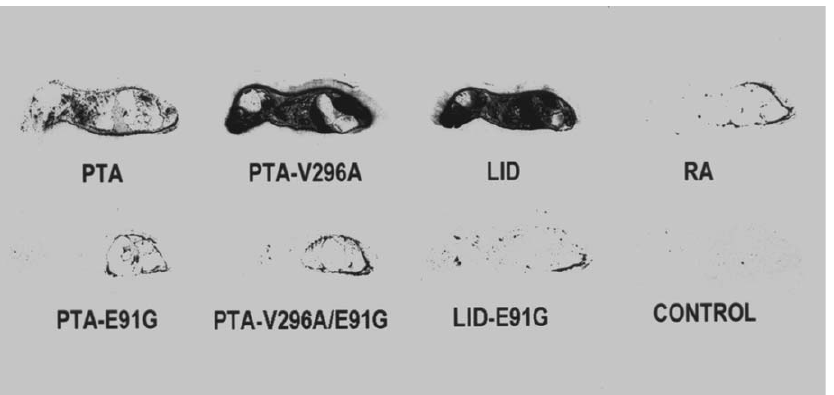
Figure 1. Effects of Single Amino Acid Replacements in Vp1 on Replication and Spread in Neonatally Infected C3H/BiDa Mice Whole mouse section hybridizations were carried out one week after virus inoculation (dose of 2 (cid:2) 5 3 10 7 pfu/animal). See Table 1 and text. Reprinted from [10] with permission from Academic Press.